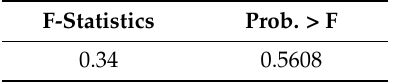
Table A12. Durbin–Wu–Hausman test with Exchange Rate Volatility